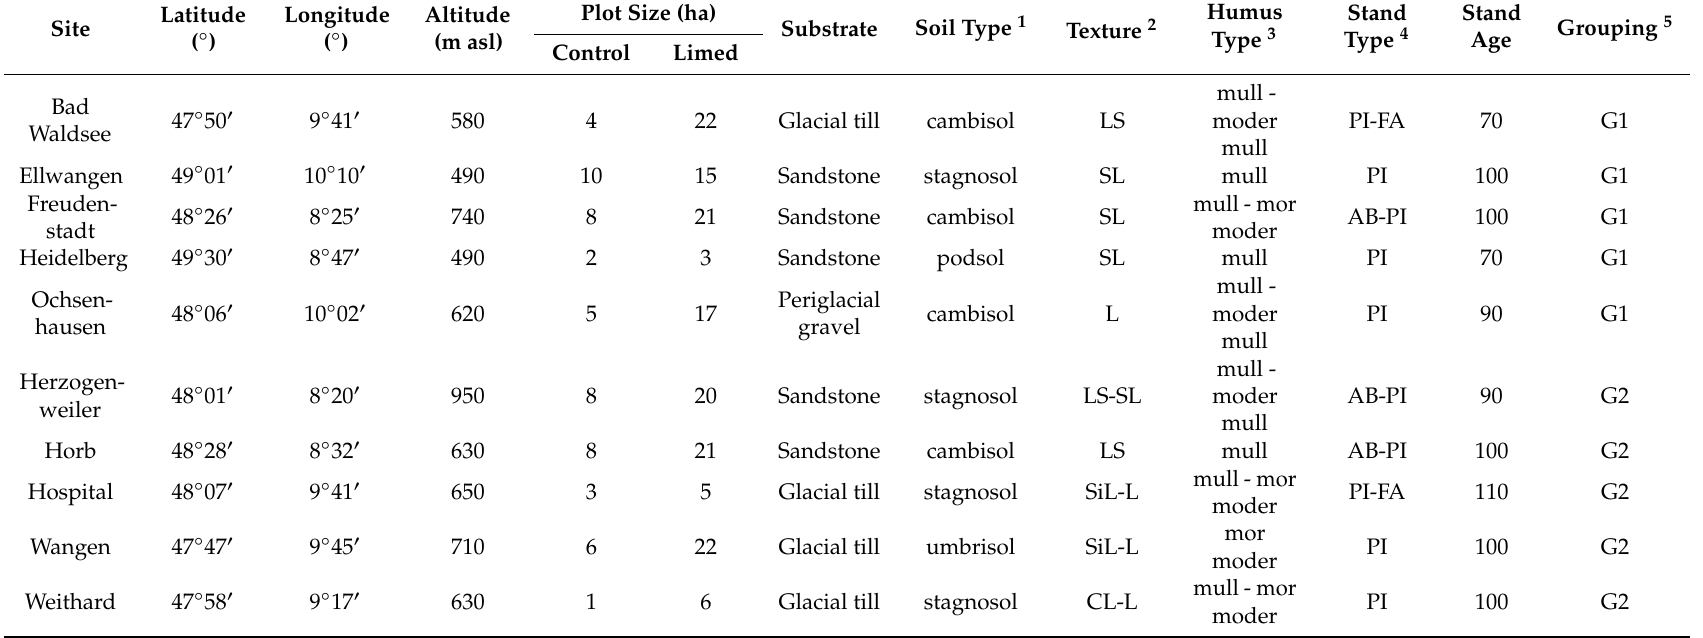
Table 1. Study sites and their key parameters in